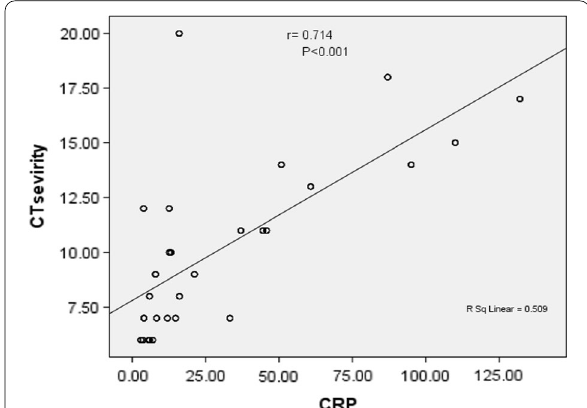
Fig. 7 Positive correlation between CT severity index and CRP level among studied cases